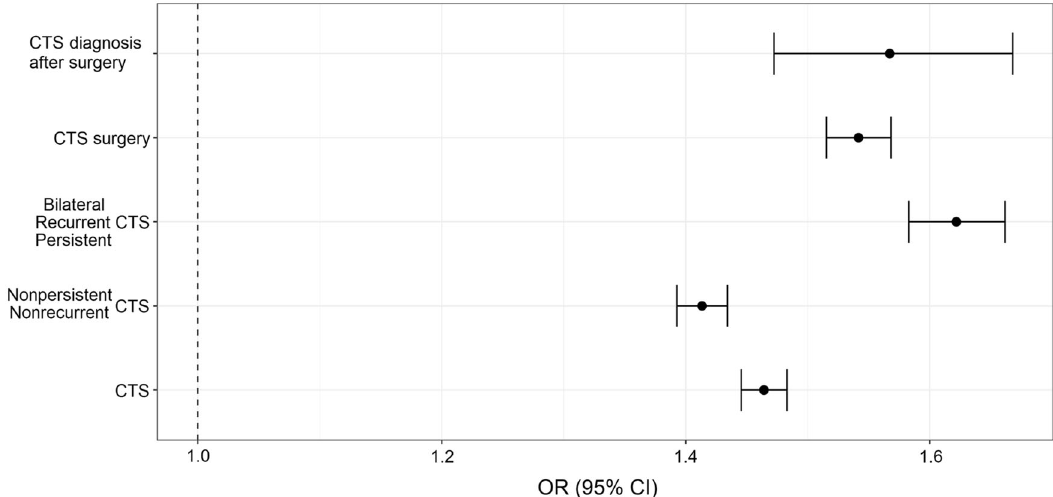
Fig. 3 Genetic propensity for CTS in suggested severity groups. The results from the PRS analyses were meta-analyzed 58 (see Supplementary Fig. 4 for each dataset). The point estimate of the OR and 95% CI (error bars) adjusted for genomic in fl ation on x-axis, were estimated in each group,